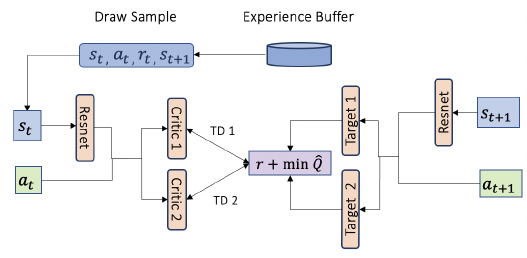
Figure 4. Schematic illustration of Double Critic Deep Q learning